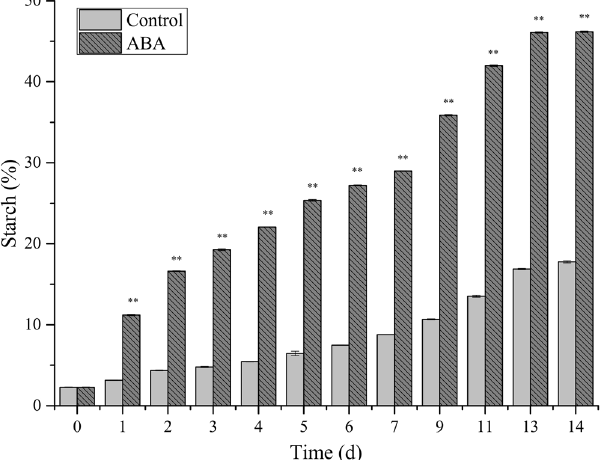
Figure 2. Starch percentage of ABA-treated L. punctata . Fronds were collected at different time points and used for starch percentage analysis. The starch percentage was calculated based on dry weight. Each data point represents the mean of triplicate values; error bars indicate standard deviation.